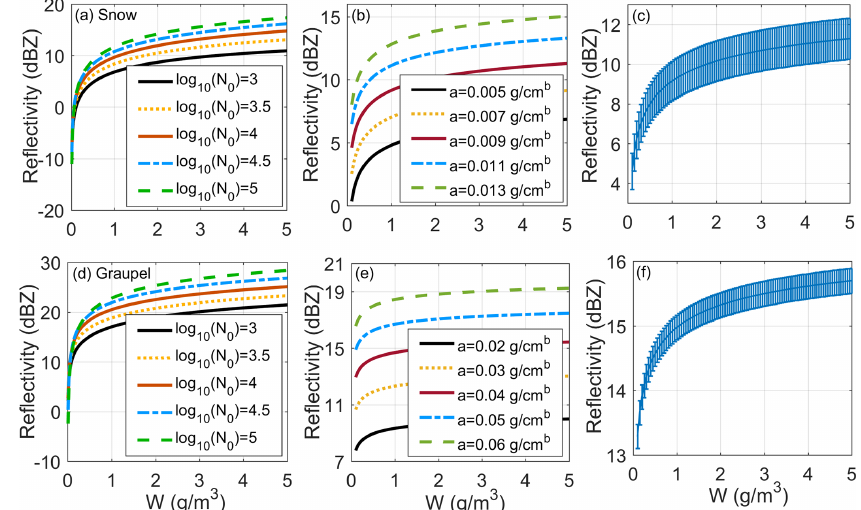
Figure 4. Impact of PSD parameters on radar reflectivity for snow and graupel. Variation in reflectivity for snow at (a) log 10 (N 0 ) values of 3, 3.5, 4, 4.5, and 5 with a mean mass–diameter relationship of m = 0 . 009 D 2 . 1 , where D is in centimeters, and m is in grams; (b) pref- actor a in a mass–diameter relationship of 0.005, 0.007, 0.009, 0.011, and 0.013gcm − b , with exponent b of 2.1 and N 0 assumed to be 3 × 10 3 m − 3 mm − 1 ; (c) mean value ± standard deviation of b , where the mean is 2.1, and the standard deviation (SD) is 0.28, with a as- sumed to be 0.009. The vertical bars represent the SD of the reflectivity change caused by deviation from the mean value of b . Variation in reflectivity for graupel at (d) log 10 (N 0 ) values of 3, 3.5, 4, 4.5, and 5 with a mean mass–diameter relationship of m = 0 . 04 D 2 . 6 , where D is in centimeters, and m is in grams; (e) prefactor a in a mass–diameter relationship of 0.02, 0.03, 0.04, 0.05, and 0.06gcm − b , with exponent b of 2.6 and N 0 assumed to be 4 × 10 3 m − 3 mm − 1 ; and (f) mean value ± standard deviation of b , where the mean is 2.6, and the standard deviation is 0.16, with a assumed to be 0.04. For a and b we took literature values from a list of studies and calculated the mean, and the standard deviation of b for snow and graupel is calculated according to the range and average of the Gaussian distribution.